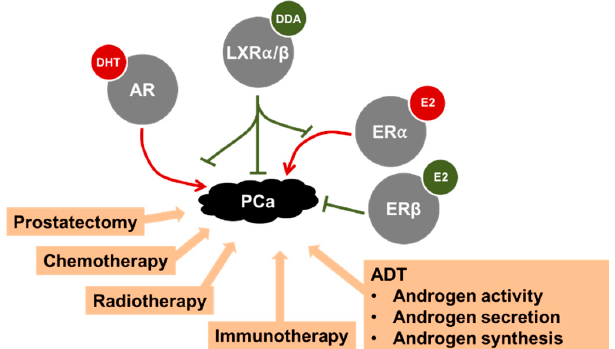
Figure 3. Summary of the various treatments proposed to treat PCa. A focus is made on some nuclear receptors. The androgen (AR) and estrogen receptor (ER) α have deleterious effects on prostate cancer (PCa) progression when activated by their respective ligands dihydrotestosterone (DHT) and 17 β -estradiol (E2). Conversely, nuclear oxysterol receptors (LXR α / β ) and ER β block the progression of PCa in animal models when activated by their respective ligands. As indicated, AR and ER α activity in PCa could be modulated by LXRs, directly or indirectly. For more details see the text. DDA: dendrogenin A.